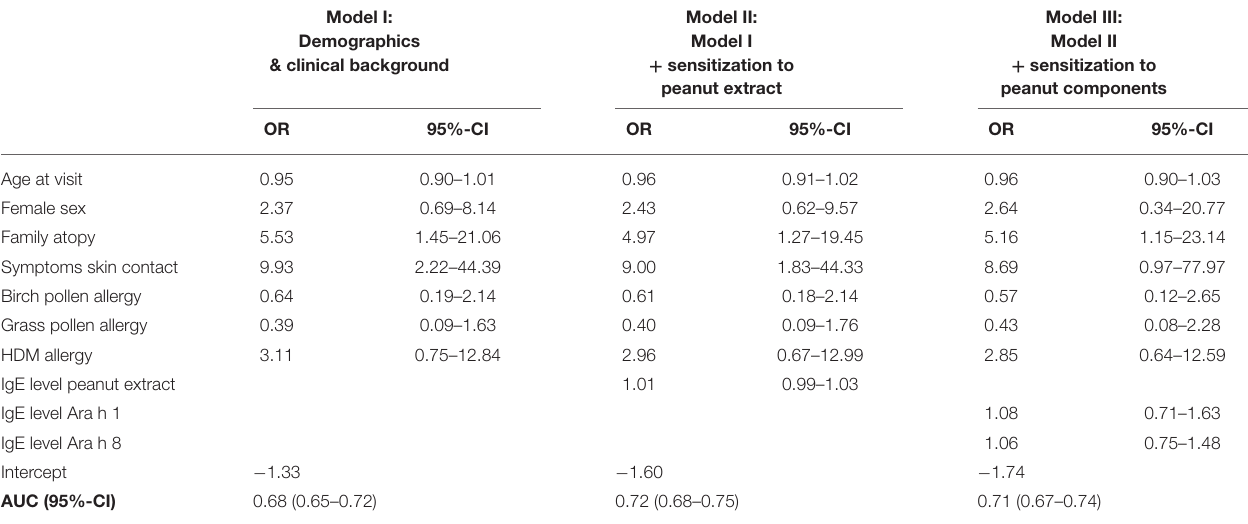
TABLE 3 | Prediction models for severity of PA according to DBPCFC or history of